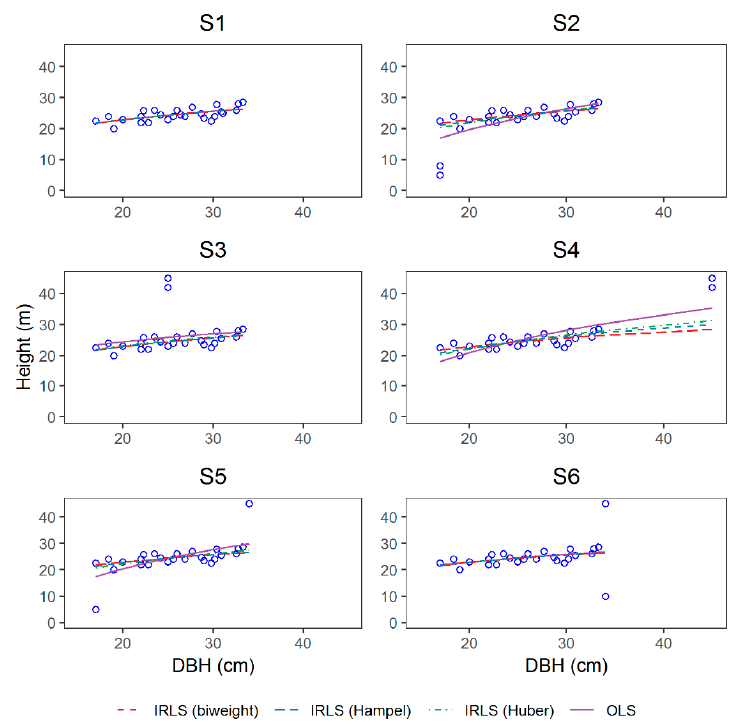
Figure 9. Predicted curves for the Henriksen’s model fitted for Ochroma pyramidale (balsa-tree) aged 4.7 years in Ecuador for six di ff erent scenarios (S1 to